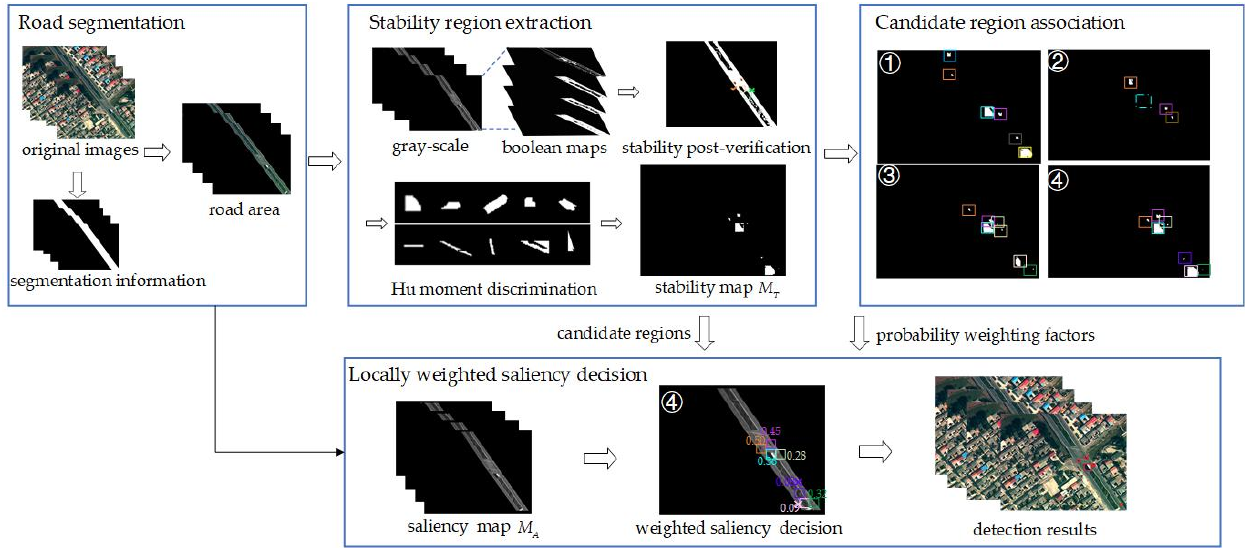
Figure 2. The framework of our method. Firstly, the original image and the segmentation information are combined by multiplication to generate the road area. Then the processed image is sent to the object detection network for stability region extraction, including gray-scale image conversion, multi-level threshold binarization segmentation and other steps to obtain the candidate regions of vehicles and a stability map. Then, we perform candidate region association based on the relative position relationship and appearance similarity of candidate regions in different frames to generate probability weighting factors. Both candidate regions and probability weighting factors are used for locally weighted saliency decision to remove false candidate regions(such as the pink detection box with score of 0.09 in the forth image) and obtain final detection results.